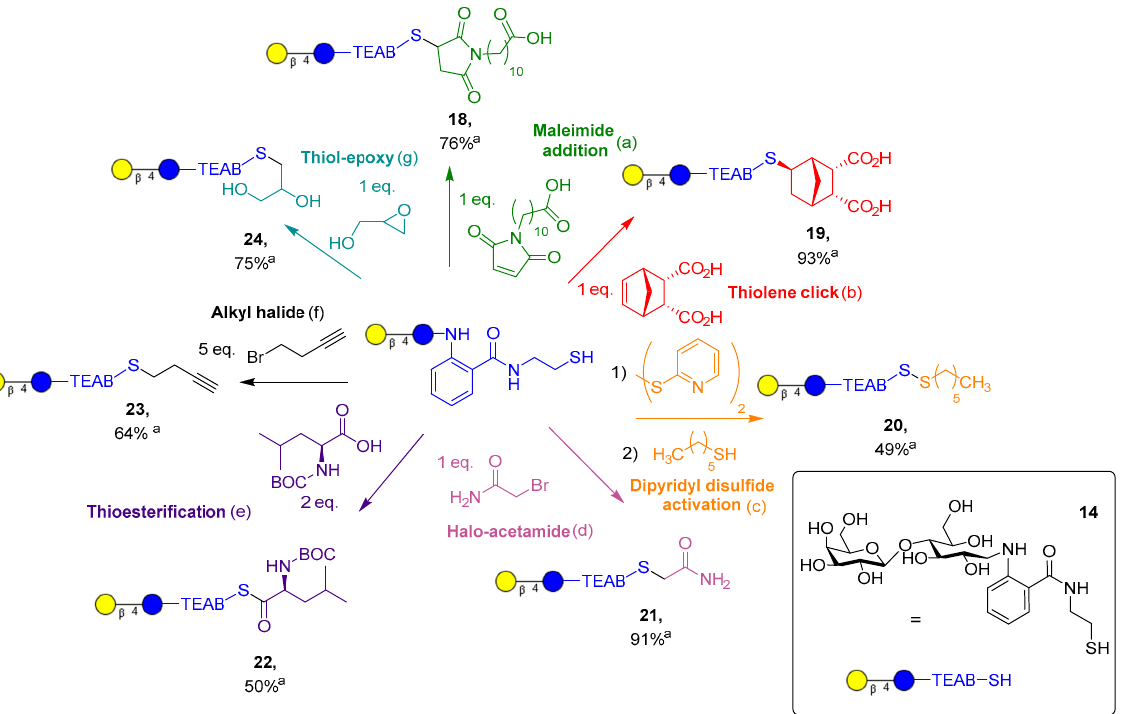
Figure 4. Synthesis of TEAB-modified lactose targets. a Isolated yield. (a) (NH 4 ) 2 CO 3 (1 eq.), water, 30 min; (b) LAP (0.05% w / v ), water, 30 min irradiation at 365 nm, 10 mW/cm 2 ; (c) (1) dipyridyl disulfide (25 eq.), DMF, 10 min; (c) (2) hexane thiol (2 eq.), DMF, 30 min; (d) (NH 4 ) 2 CO 3 (1 eq.), water, 2 h; (e) DCC (2 eq.), DMAP (0.1 eq.), DMF, 2 h; (f) TCEP (0.7 eq.), (NH 4 ) 2 CO 3 (1 eq.), MeOH, 65 °C, 8 h; (g) (NH 4 ) 2 CO 3 (1 eq.), water, 1.5 h.